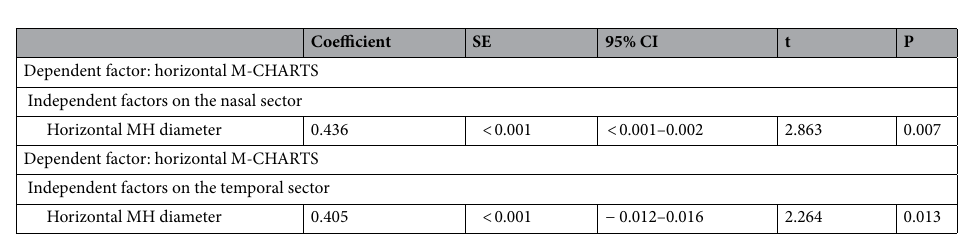
Figure 2. Correlations between pre- and postoperative differences in M-CHARTS score and changes in inner nuclear layer and outer retinal layer thickness at 1 month postoperatively. Plots shows the correlations between difference in horizontal M-CHARTS score and rate of change in temporal and superior inner nuclear layer thickness ( a ) and the rate of change in superior outer retinal layer (OR) thickness ( b ), and the difference in vertical M-CHARTS score correlated with the rate of change in superior OR thickness ( c ) at 1 month postoperatively. Spearman’s rank correlation coefficient was used to determine the significance of the correlations.